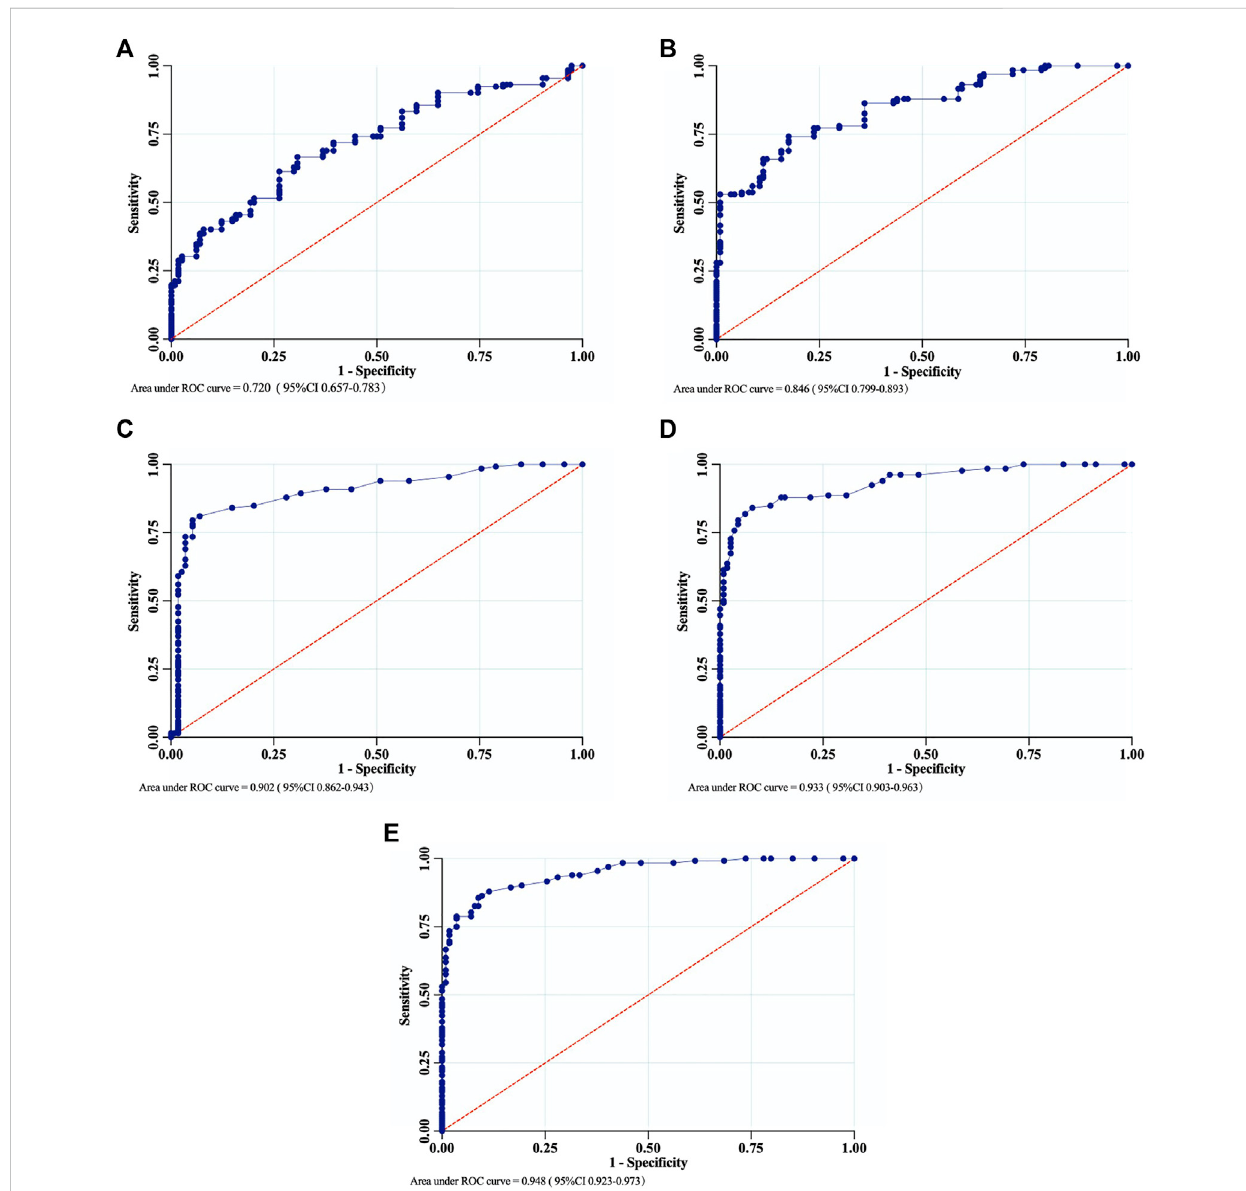
FIGURE 5 The ROC curves of the Ligs Digital Arthrometer for the diagnosis of complete ACL ruptures. (A) 30 N; (B) 60 N; (C) 90 N; (D) 120 N; (E) 150 N.